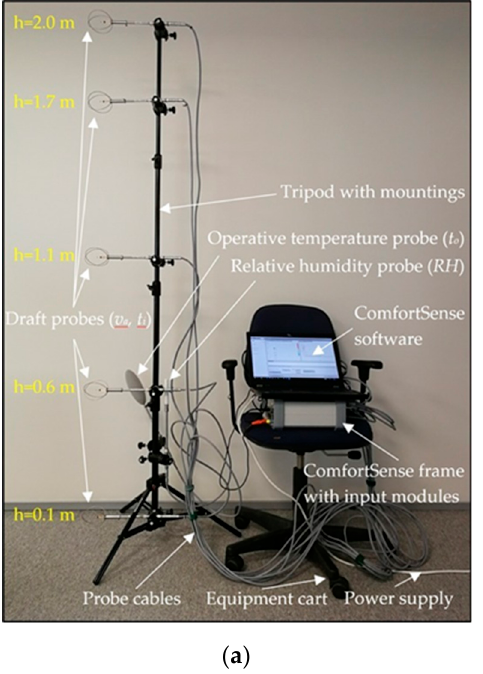
Figure 4. Tripod setup ( a ) for measuring the thermal comfort and ( b ) positioning of heating dummies (circles) and measuring tripod (cross).